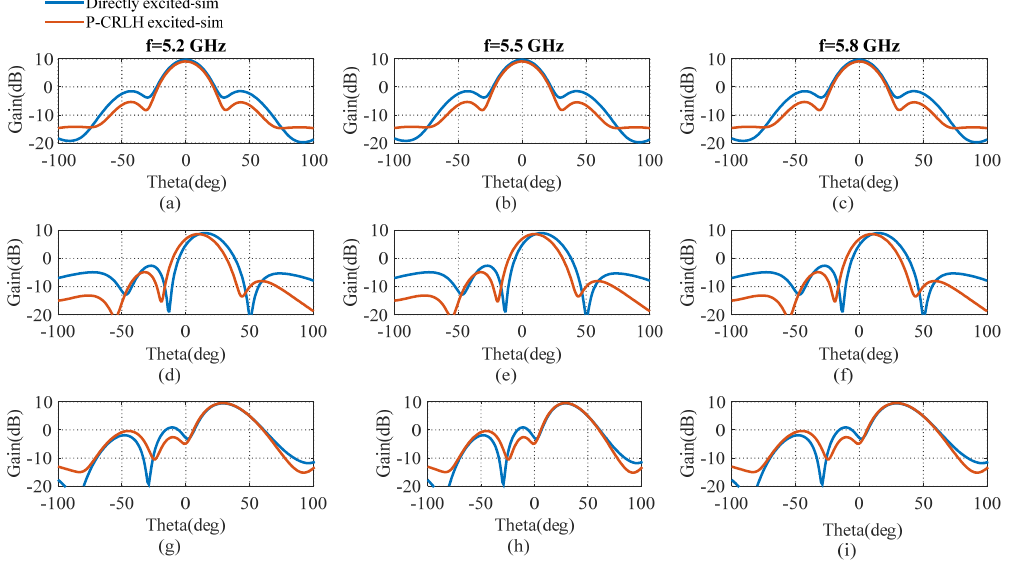
Figure 6. Simulation results of a 1 × 4 P-CRLH excited cylindrical phased array operating in C-band: ( a – c ) broadside patterns, ( d – f ) scanned patterns at 15 ° and ( g – i ) scanned patterns at 30 ° . 5. Measurement Results of a Cylindrical Phased Array with P-CRLH Phase Shifters Next, to validate the simulation results, four cascaded unit cells of the P-CRLH phase shifter were manufactured on a TMM4 substrate ( ε r = 4.7, tan δ = 0.002, and thickness = 0.635 mm). The silver-coated micron-sized magnetic particles used through- (CONDUCT-O-Fil, part number SM25P20) [30]. MRSs cavities were drilled through the